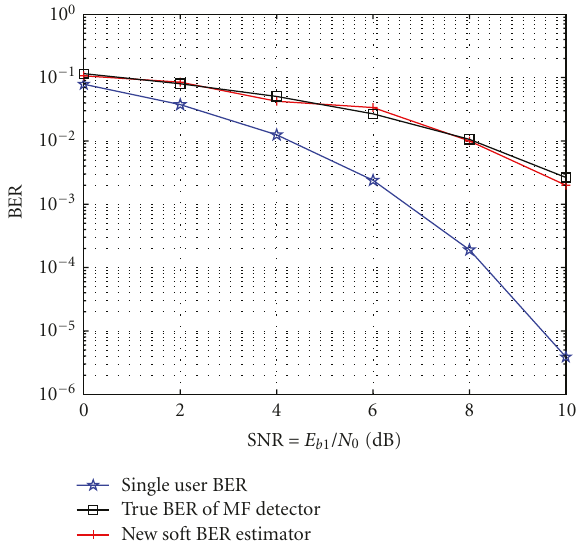
Figure 3: Soft BER algorithm and true BER comparison for synchronous CDMA